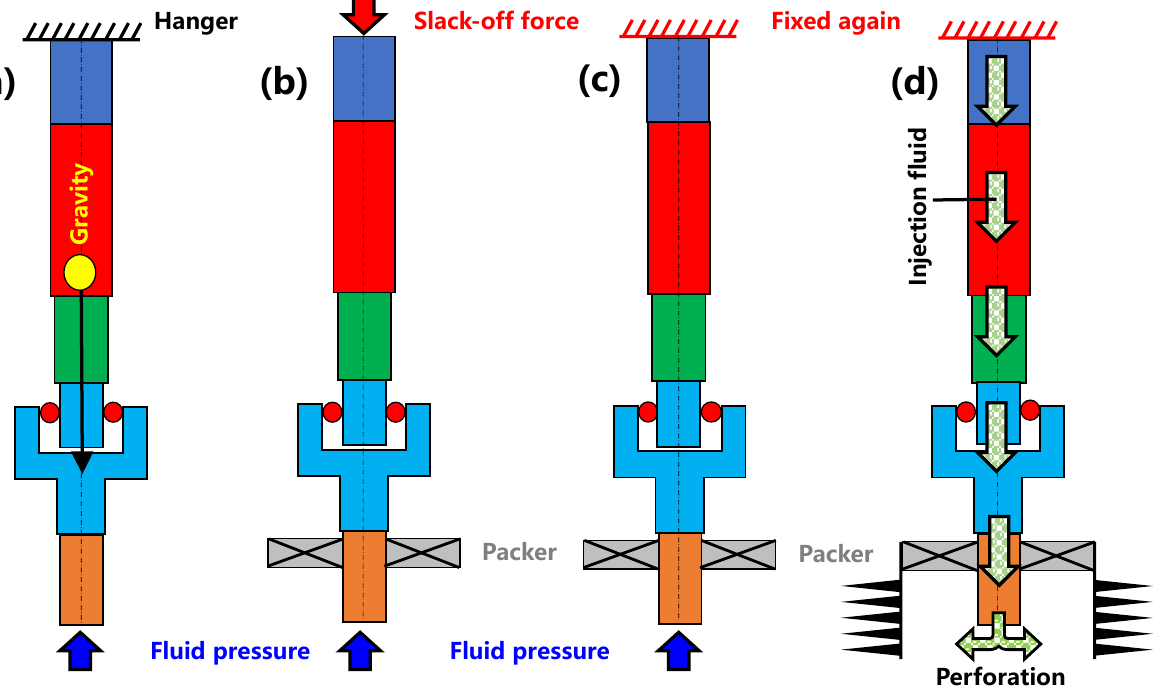
Figure 9. The load application procedures for the whole section of tubing string: ( a ) gravity, ( b ) packer setting and slack-off force, ( c ) fix wellhead again, and ( d ) injection.